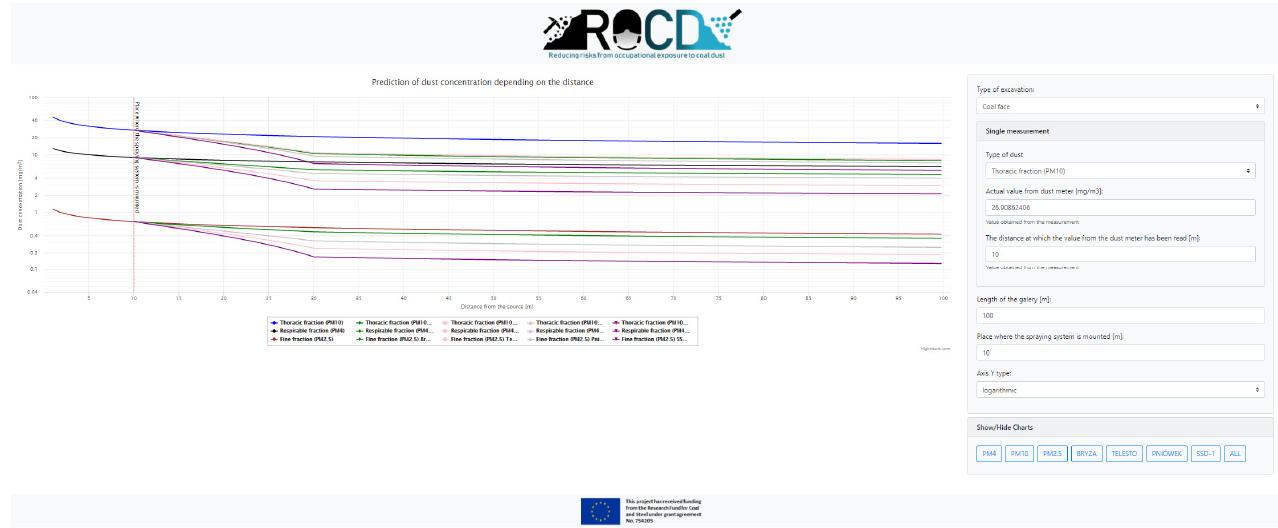
Figure 21. View of the dust prediction application, showing a graph of dust concentration depending on the distance from the dust